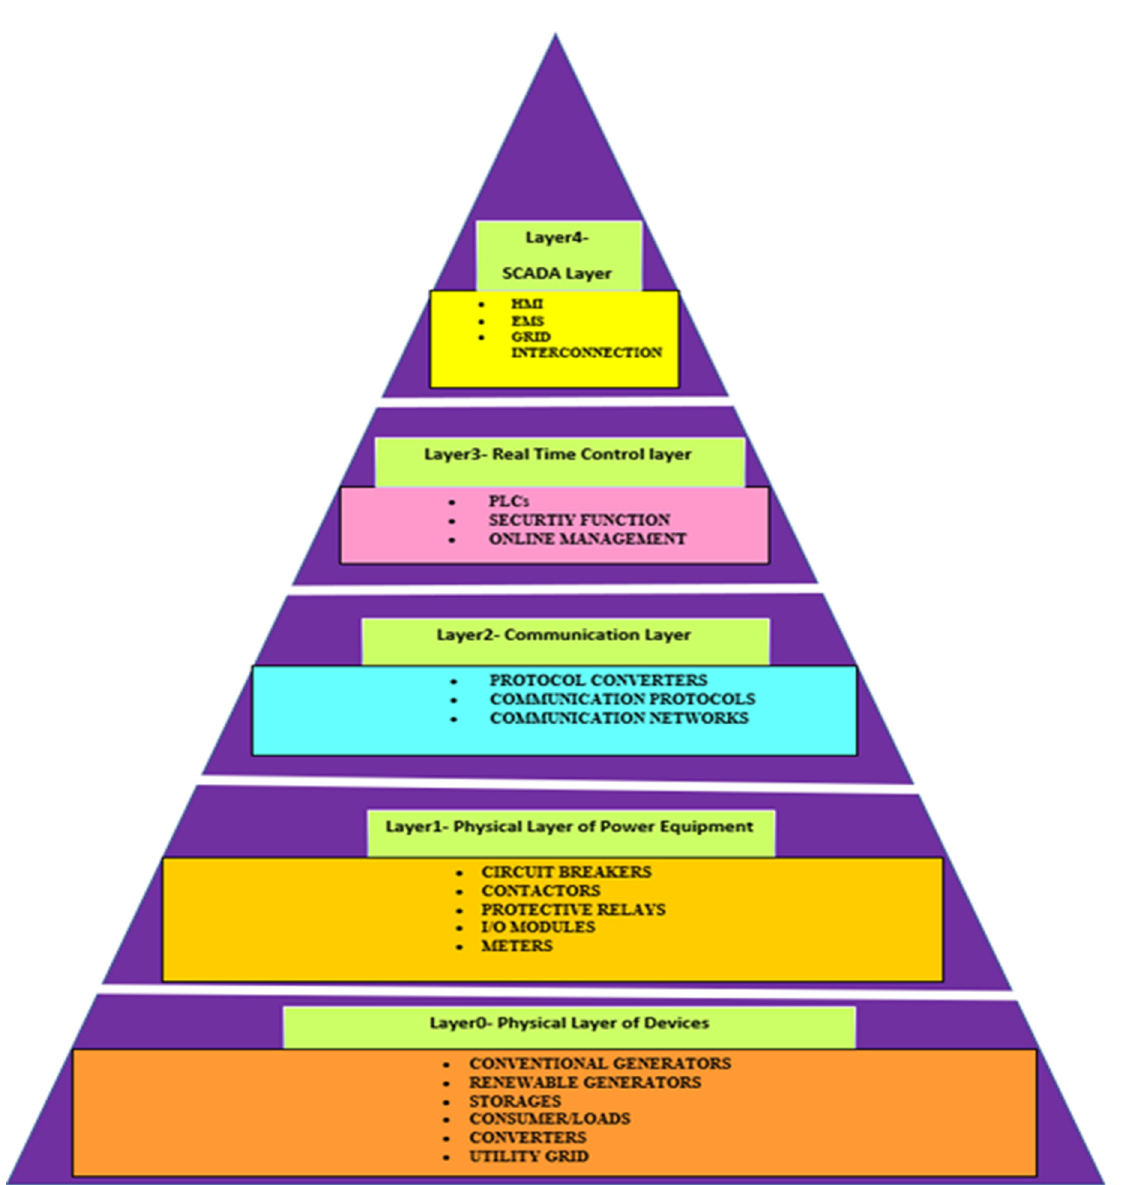
Figure 4. PrInCE Lab microgrid management layers.